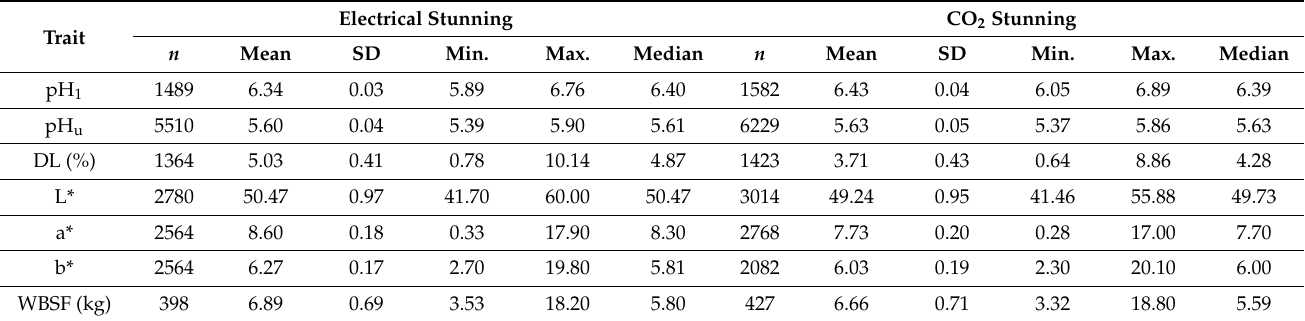
Table 2. Descriptive statistics of parameters included in the